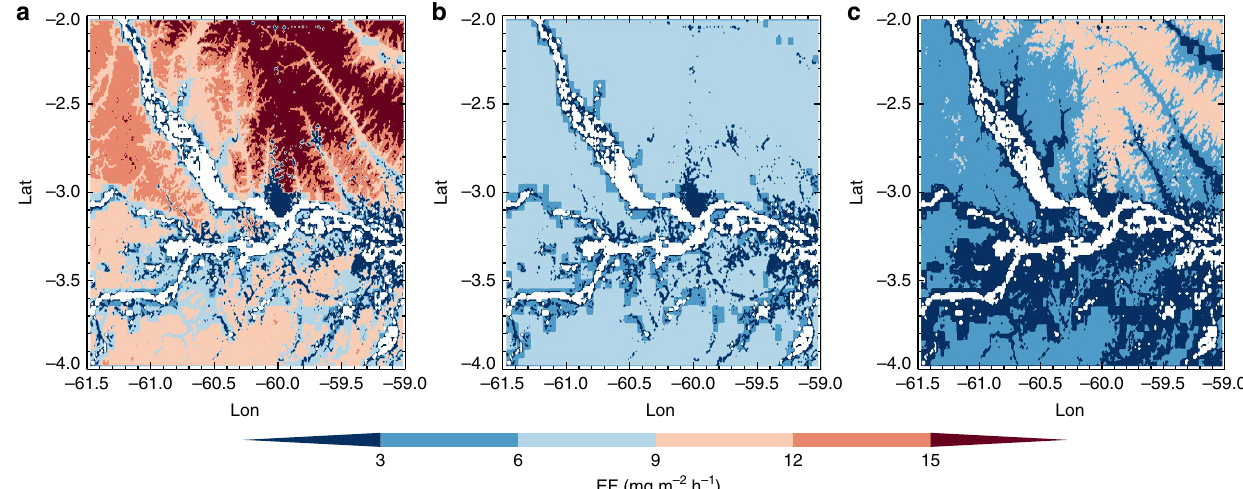
Figure 4 | Distribution of isoprene EF. Comparison of isoprene EFs based on observations from airborne EC approach ( a ), based on MEGANv2.1 EFs and MODIS PFT land cover observations ( b ) and the difference between the above two data sets ( c ).